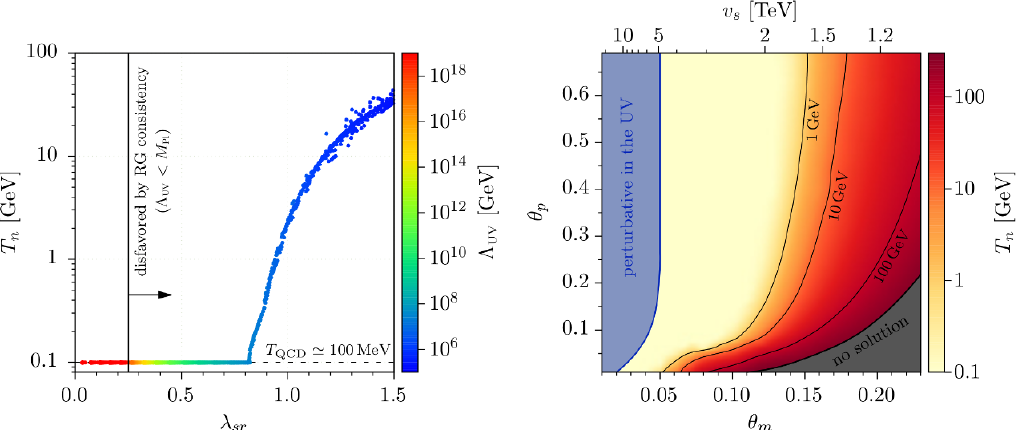
Figure 1 . Temperature T n at which the electroweak phase transition (EWPT) completes in the minimal scale-invariant model. Since the EWPT is at the latest induced by the chiral phase tran- sition of QCD, we never show nucleation temperatures below T ’ 100 MeV. Both panels are QCD based on the same set of parameter points, which was constructed using the method outlined in section 2.2 and assuming that the SM-like Higgs is the lightest of the CP-even scalar eigenstates at tree-level . Left : T n plotted against the portal coupling (cid:21) sr . The color code indicates the lowest RG- . M scale (cid:3) at which a Landau pole appears. In particular, only the red points for which (cid:3) UV UV Pl are fully consistent in the sense that they can stabilize the electroweak against the Planck scale. Right : T n (color code and black contours) in the plane spanned by (cid:18) p and (cid:18) m or v s ,